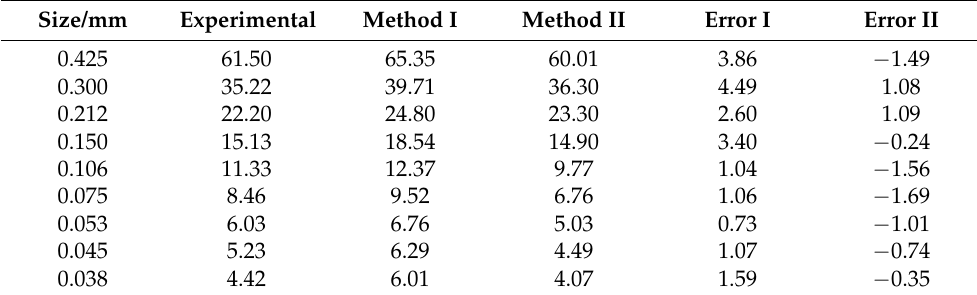
Table 9. The comparison of the simulation using the two methods (grinding for 4 min). Size/mm Experimental Method I Method II Error I Error II